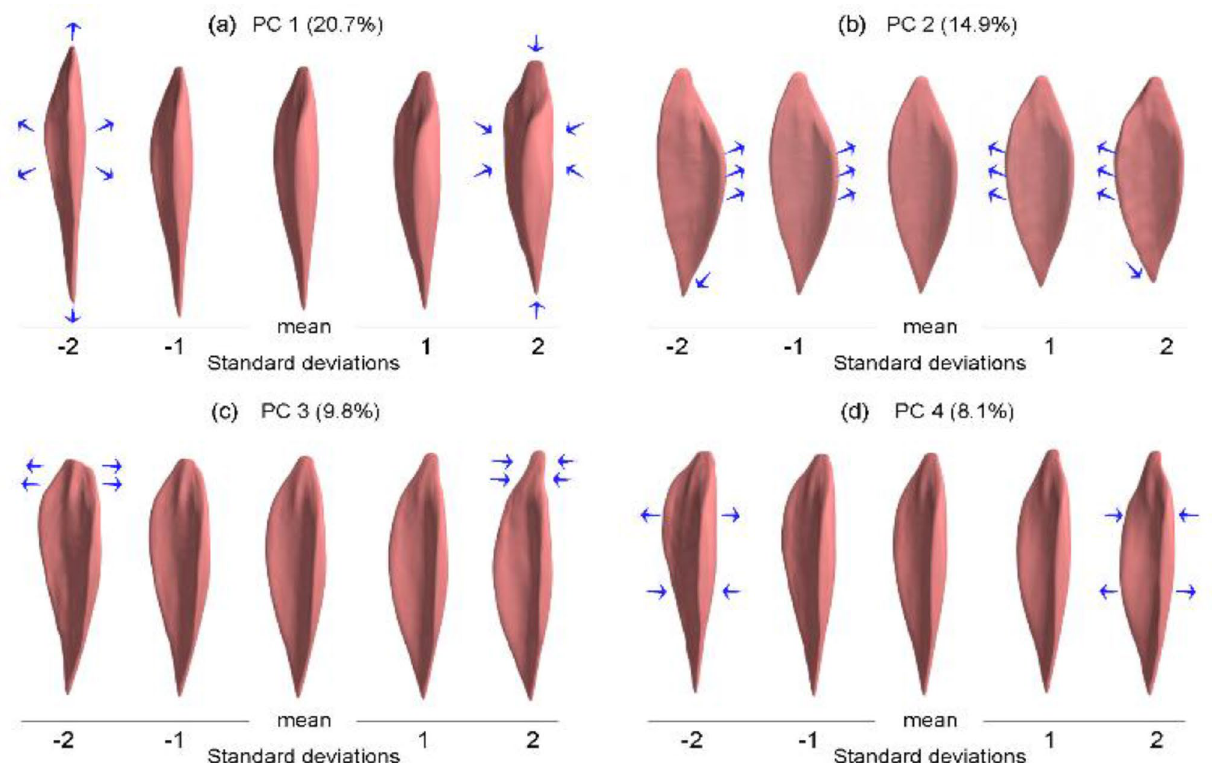
Figure 4. The variations of the soleus muscle along the principal components of the CP appearance (normalized) model and their variance percentages. The blue arrows indicate the change of the muscle shape. The first principal component ( a ) can be described as a change of the muscle length combined with an inverse change of the muscle thickness and width. The second principal component ( b ) represents a widening of the curved marginal aspect of the soleus. The third principal component ( c ) can be described as a change in the width of the proximal extremity of the muscle. The fourth principal component ( d ) represents a superior- inferior shift of the broad section of the muscle toward the muscle distal